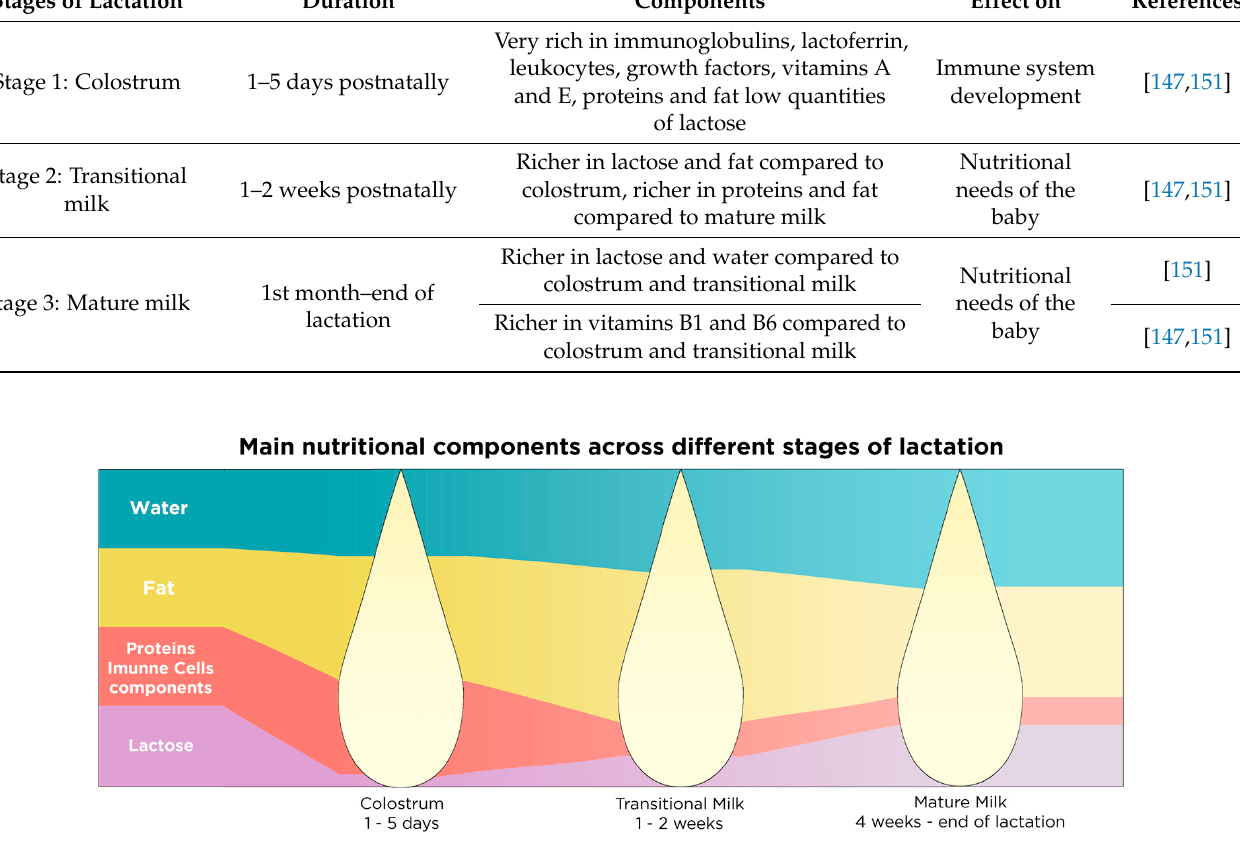
Figure 3. Main nutritional and bioactive components in the different stages of lactation. The quantity of the main nutritional components stays consistent in mature milk, after the 1st month of lactation until the cessation of